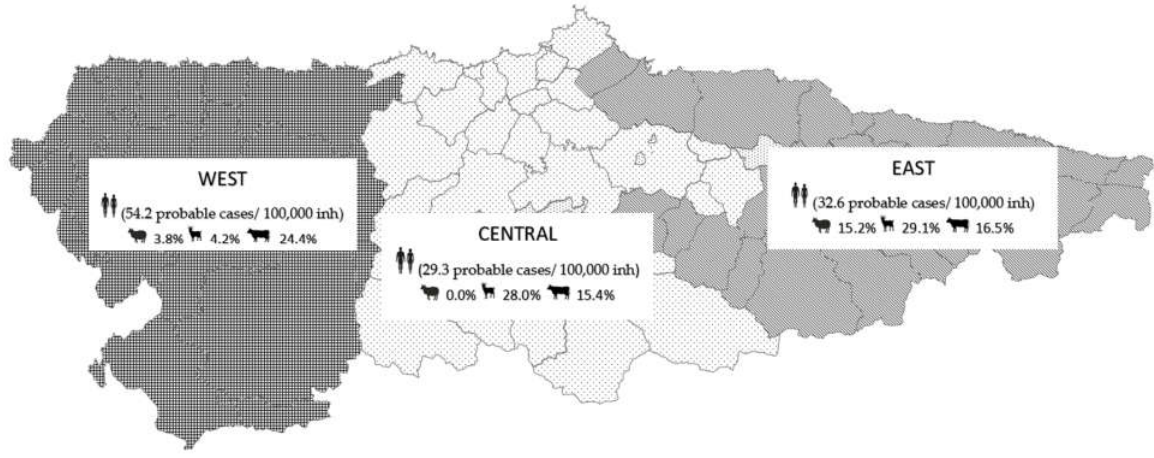
Figure 3. Map of Asturias indicating the number of probable cases of Q fever/100,000 inhabitants and the mean seroprev- alence against C. burnetii in domestic ruminants in each of the three geographical zones.